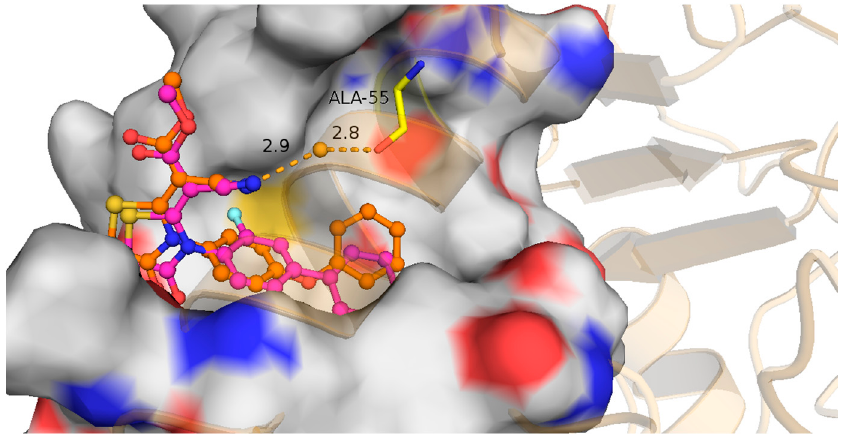
Figure 5. Binding modes of 4-thiazolidinones with biphenyl ether structure (magenta sticks: compound 10 , orange sticks: compound 19 ) .